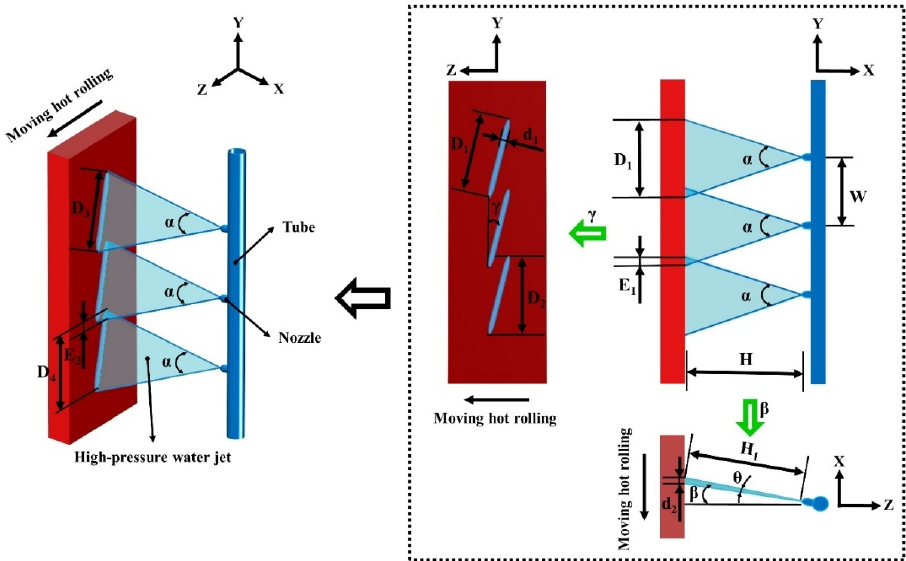
Figure 1. A schematic diagram of the high ‐ pressure water descaling nozzle configuration.